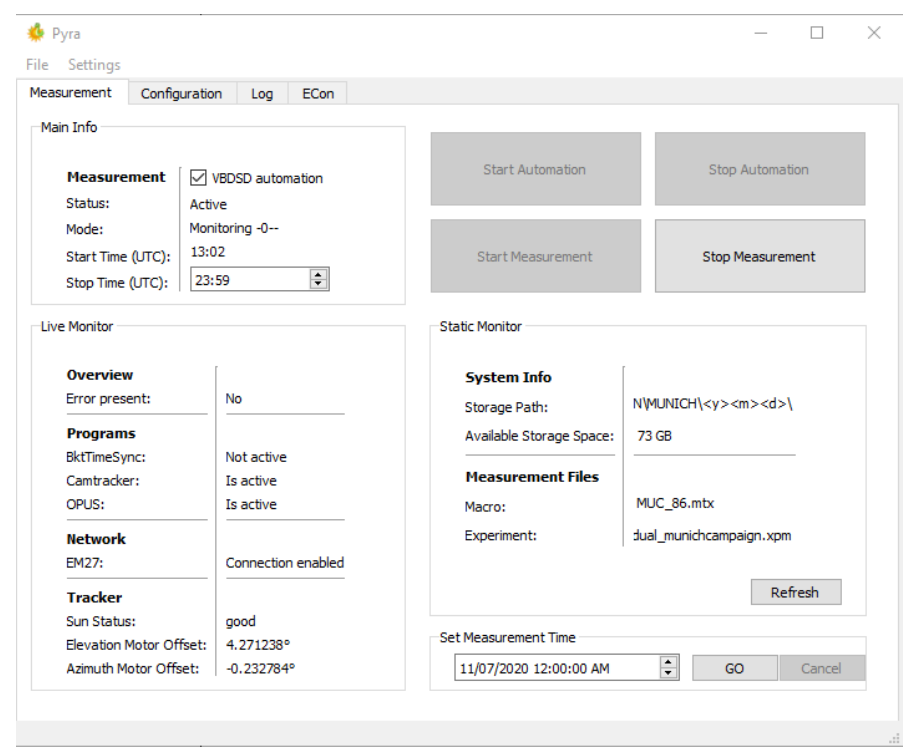
Figure 7. User interface for the control software, Pyra. In total there are four different tabs ( Measurement, Configuration, Log and Enclosure control ) that can be selected. In this image, the measurement tab is